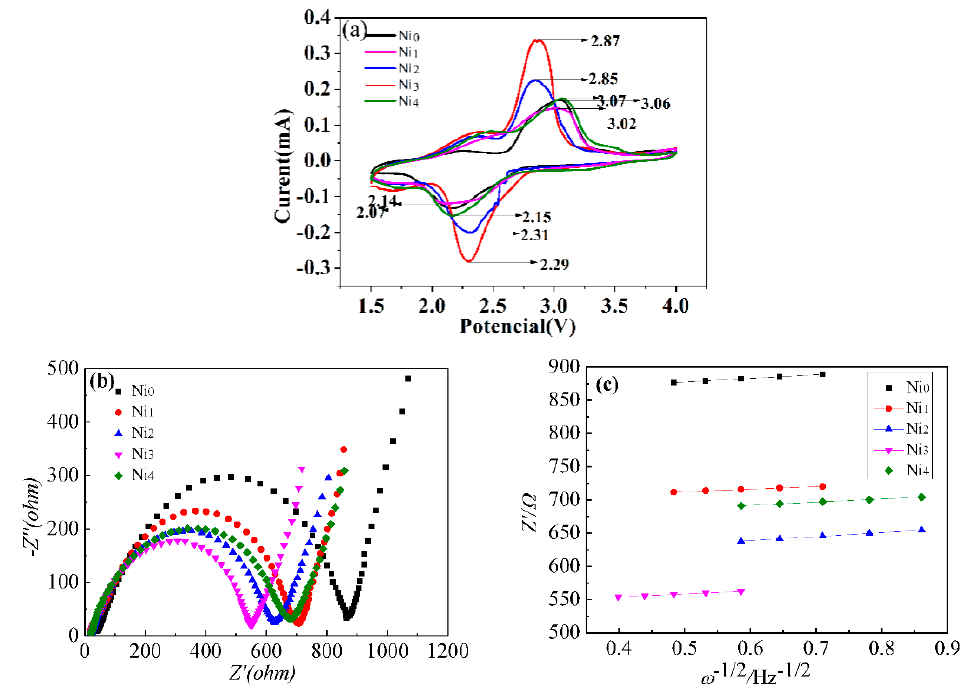
Figure 4. ( a ) Cycle voltammetry (CV) curves of Ni 0 , Ni 1 , Ni 2 , Ni 3 and Ni 4 samples. ( b ) The electrochemical impedance spectroscopy (EIS) plots of Ni 0 , Ni 1 , Ni 2 , Ni 3 and Ni 4 samples after three discharge/charge cycles. ( c ) The relationship between Z ′ and ω − 1/2 obtained from EIS plots shown in ( b ). The calculated lithium ion di ff usion coe ffi cients of Ni 0 , Ni 1 , Ni 2 , Ni 3 , Ni 4 were 2.82 × 10